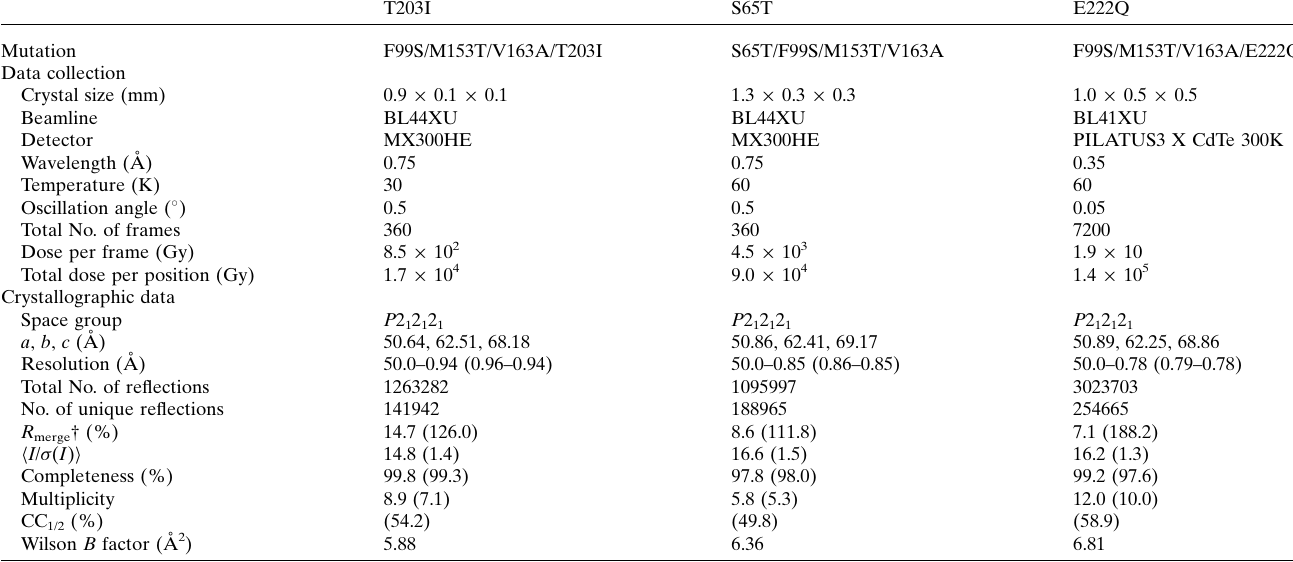
Table 1 Data-collection and crystallographic statistics. Values in parentheses are for the highest resolution